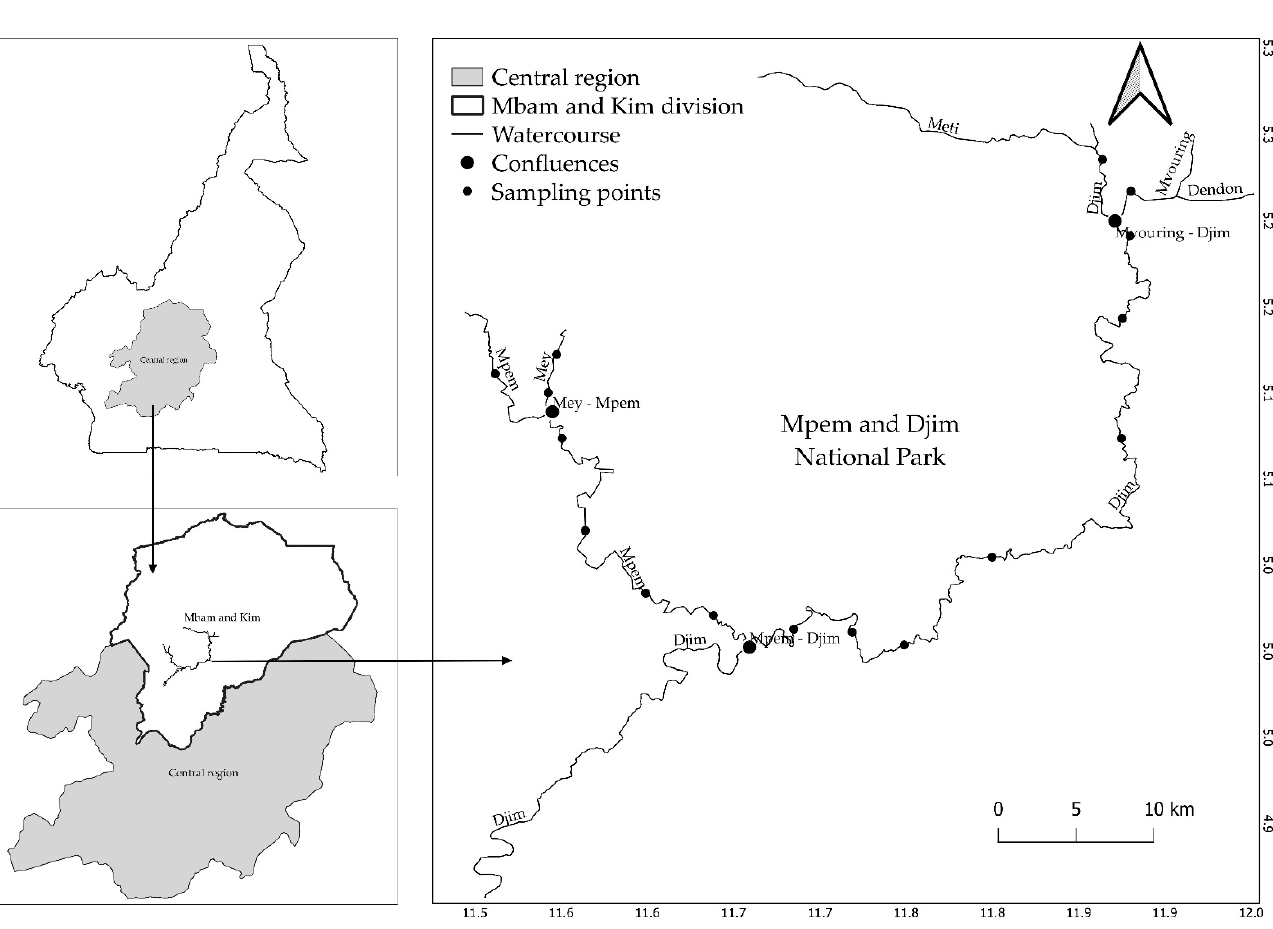
Table 1. Sampling stations and frequencies or seasons (D = dry season; R = rainy season). Sampled (X) or not sampled (empty).